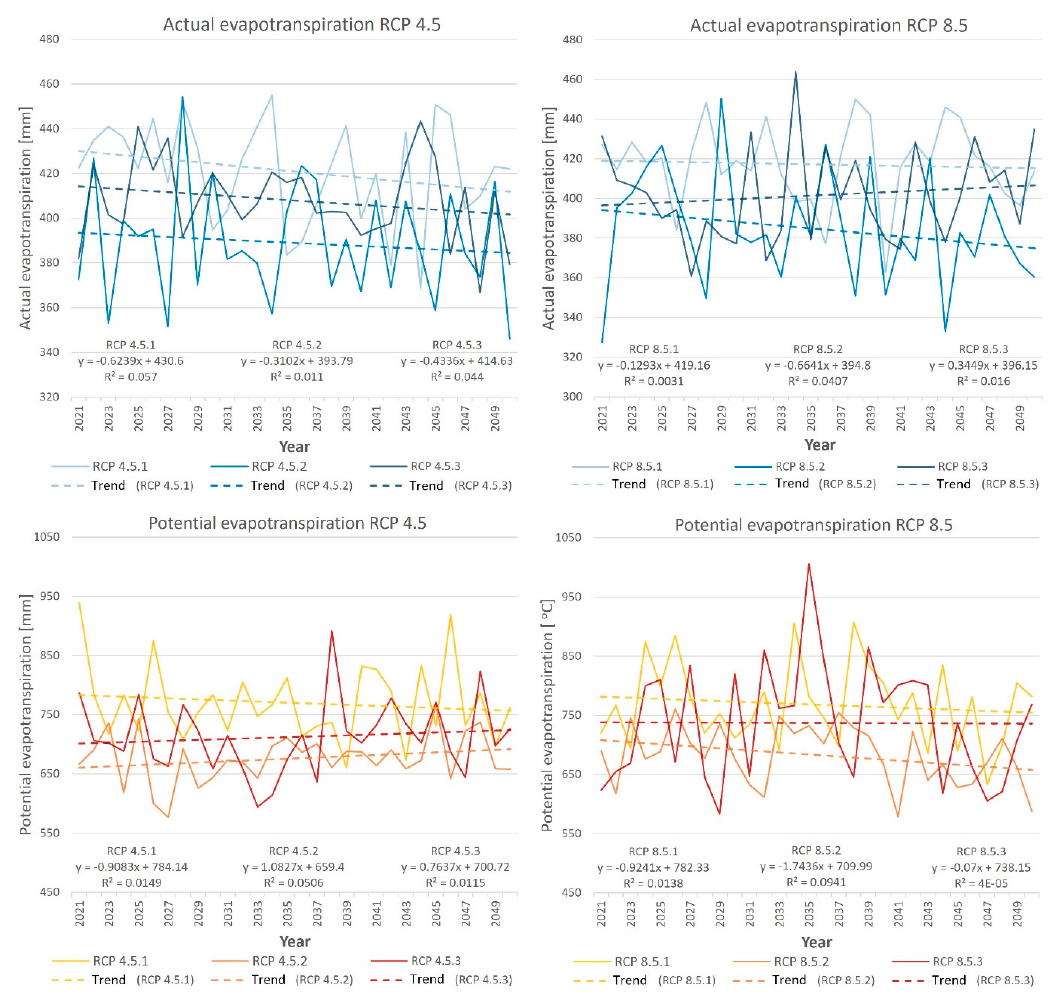
Figure 11. Average annual actual evapotranspiration and potential evapotranspiration in the catchment area of the Bystra River in the years 2021–2050 for individual climate projections in the RCP 4.5 and RCP 8.5 scenarios together with trend lines (own study).